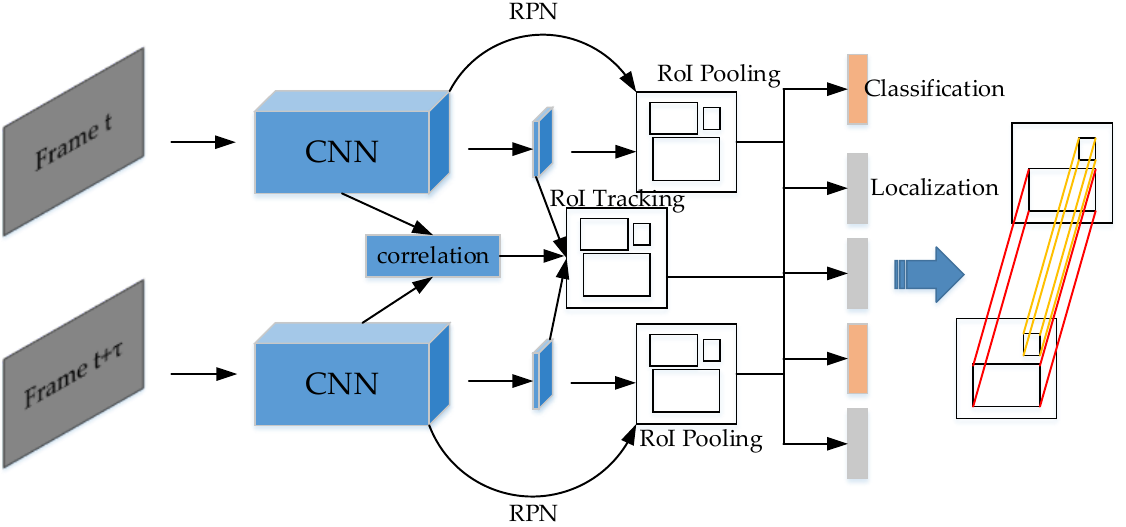
Figure 23. The illustration of Detect to Tracks and Tracks to Detect. The two CNN pipelines are correlated for the RoI Tracking, for the purpose of enhancing the video object detection.